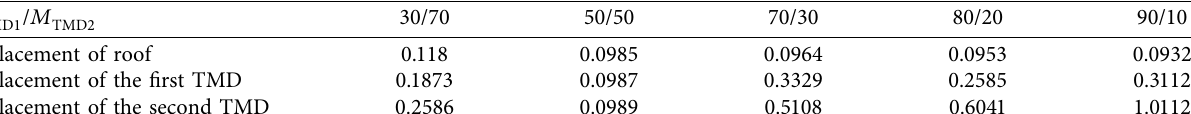
Table 5: Comparison of different mass percentages of TMDs in controlled structures with MTMD in El Centro earthquake.